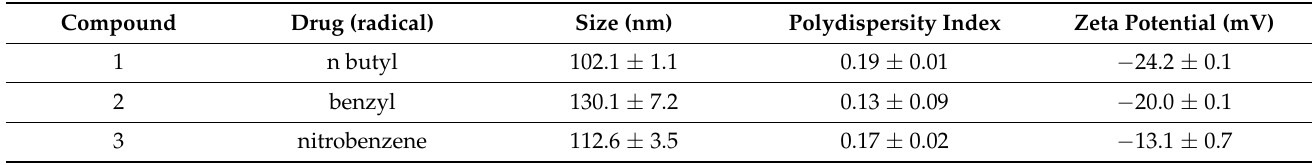
Table 1. Size (diameter) and zeta potential measurements of neutral Egg-PC liposomes encapsulating the drugs.